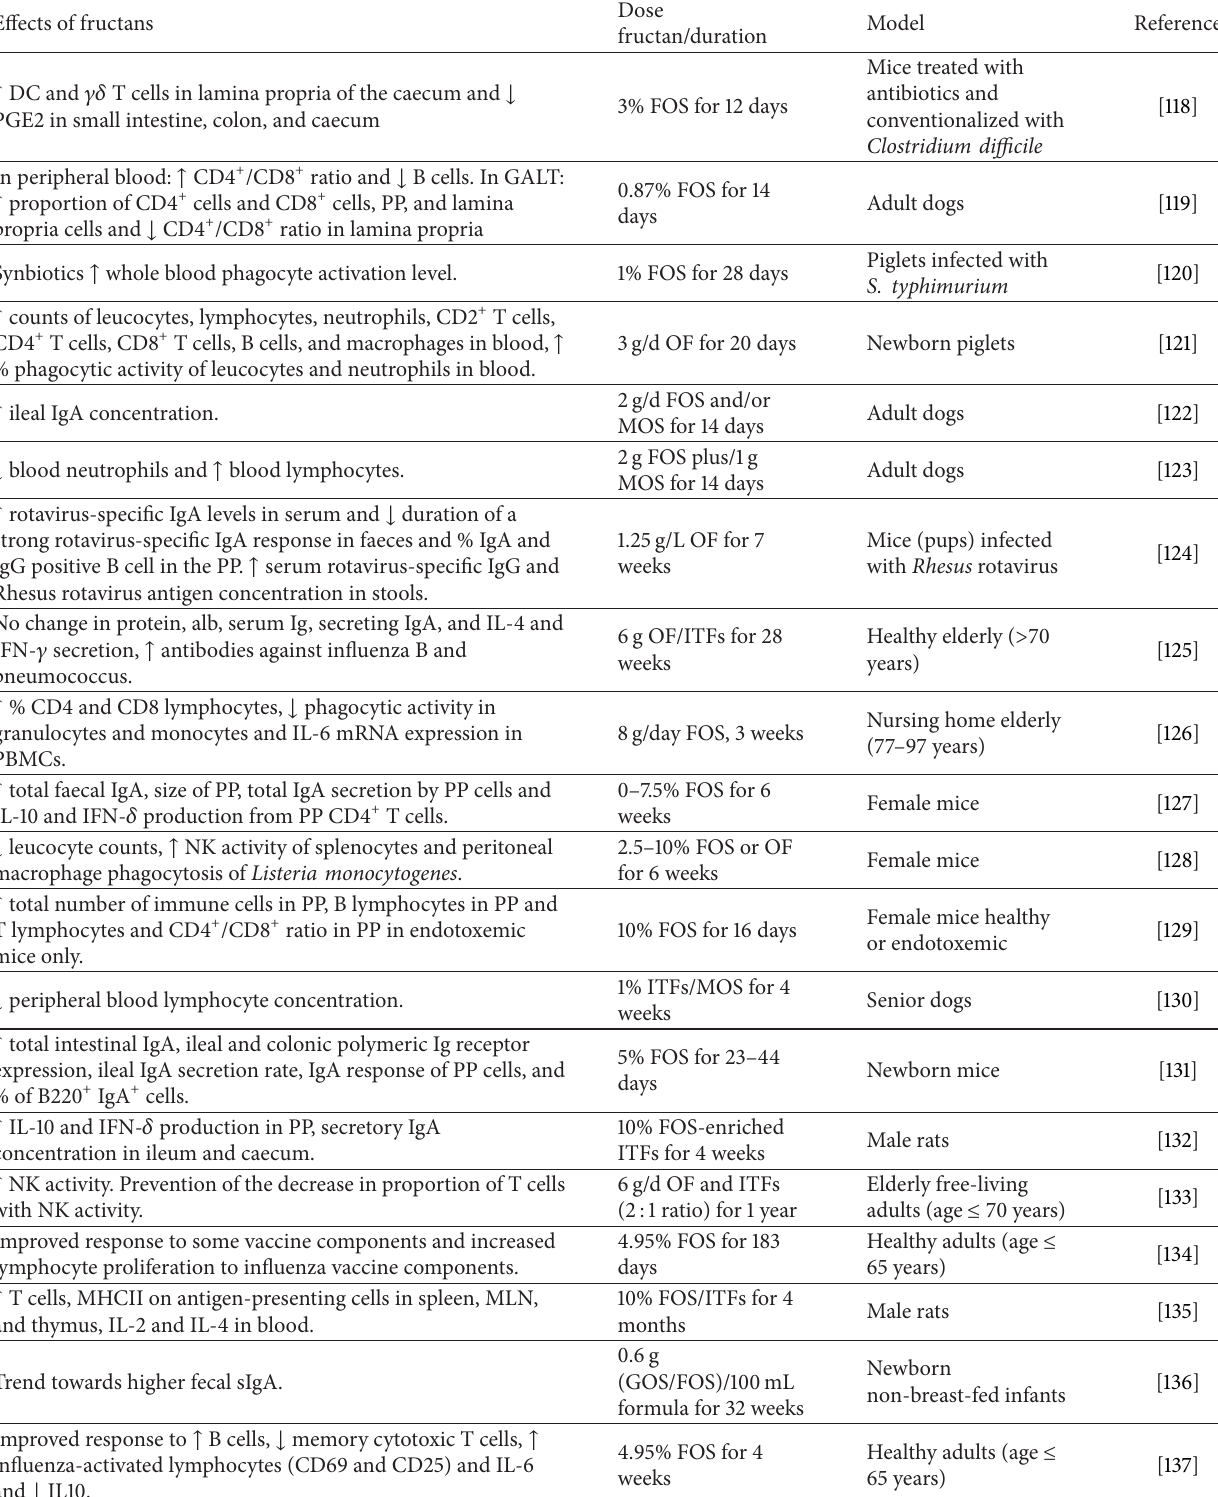
Table 2: Effect of fructans on the immune function in healthy animal and human